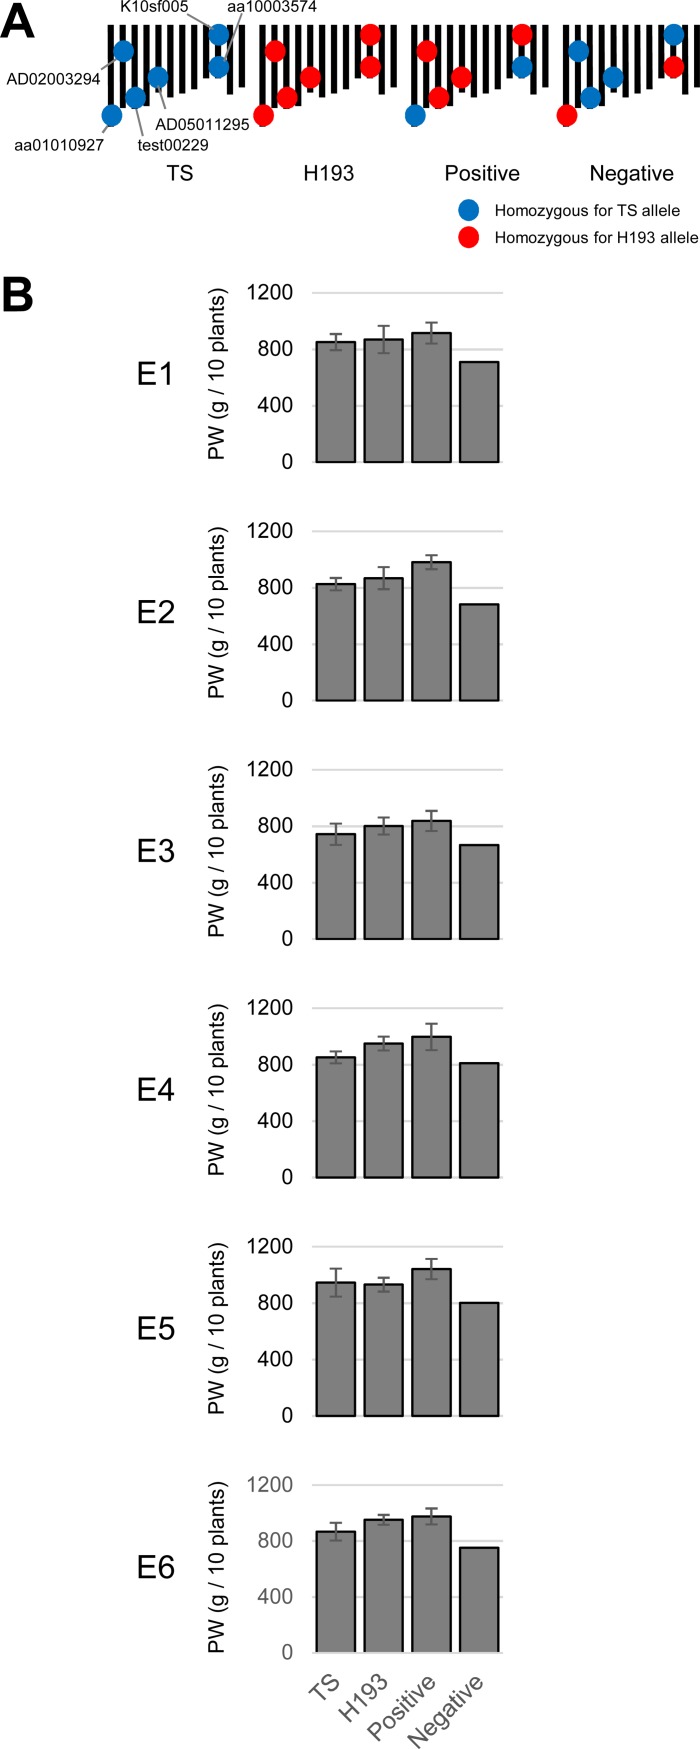
Effects of QTL alleles on plant weight.(A) Genotypes of parental cultivars and selected recombinant inbred lines (RILs). (B) Plant weights of parental cultivars (n = 7–9) and selected RILs. Values indicate means (± SD) of plant weights in each genotype class. Positive, RILs with QTL alleles with positive effect (n = 10); Negative, RILs with QTL alleles with negative effect (n = 2); PW, plant weight.